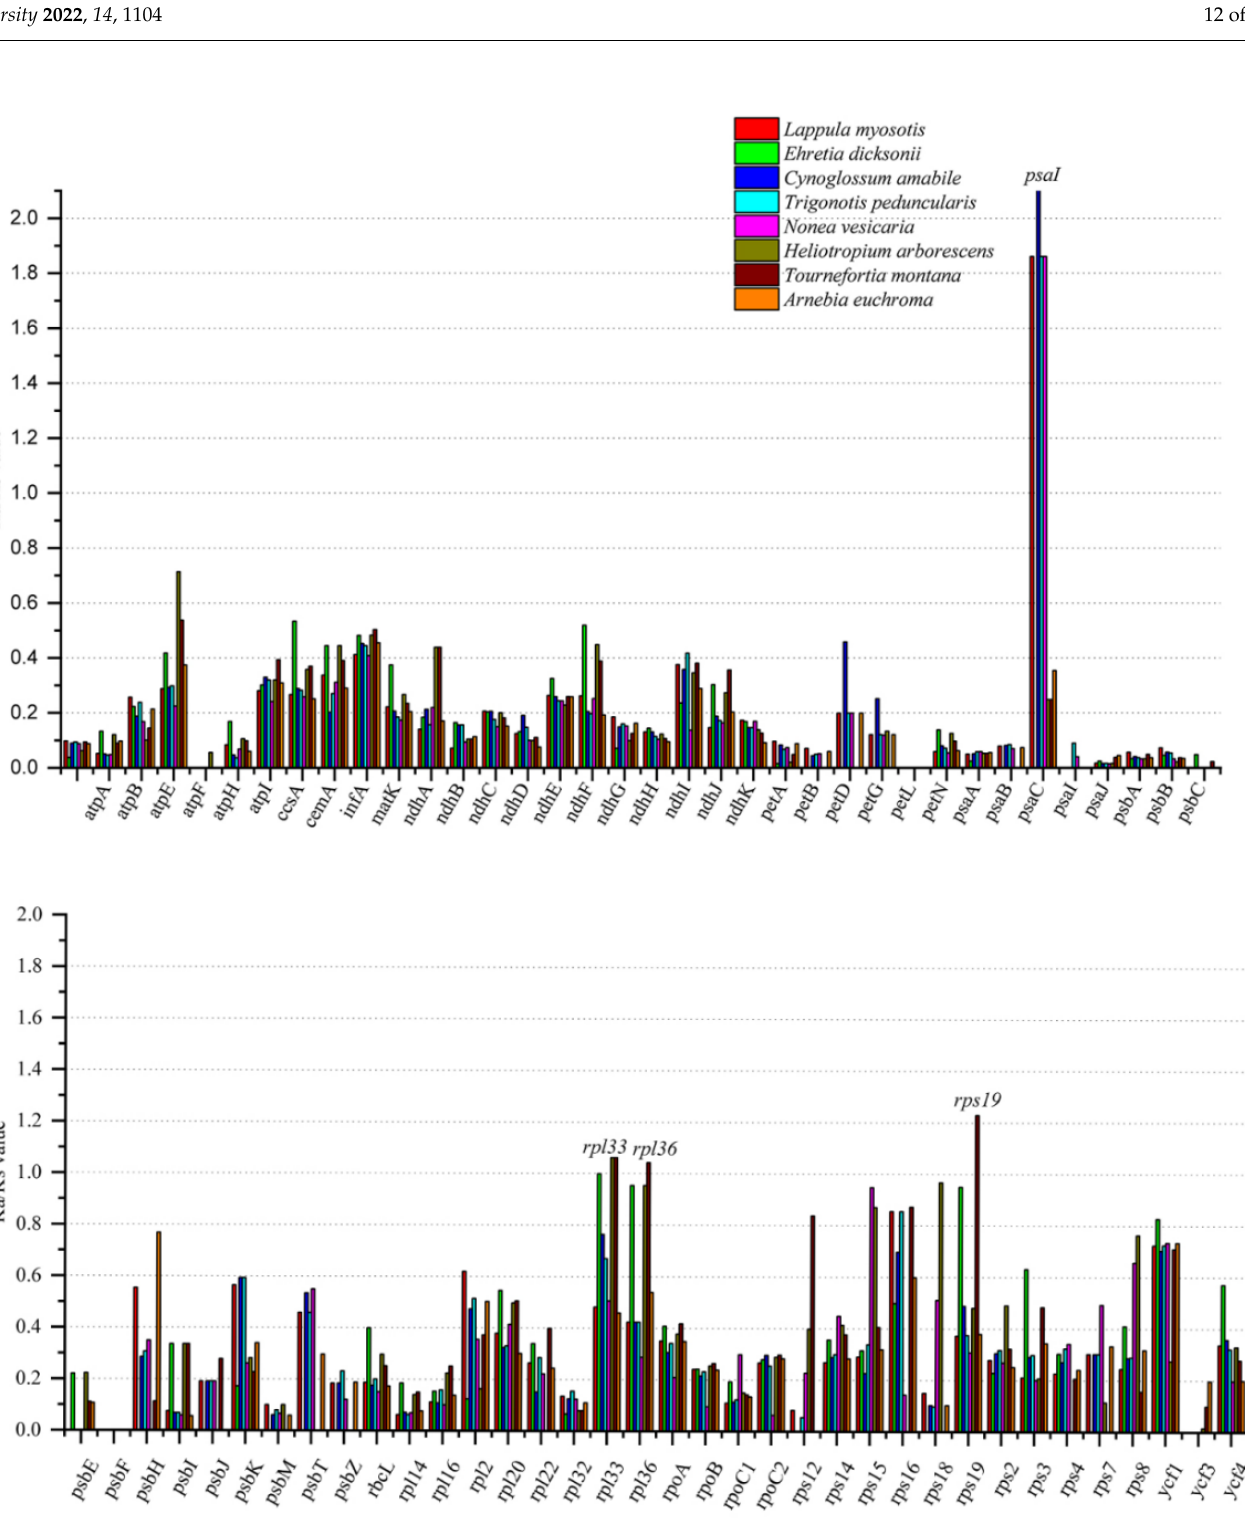
Figure 7. The Ka/Ks values of plastid genes in the nine species, with Cordia dichotoma as a reference genome.